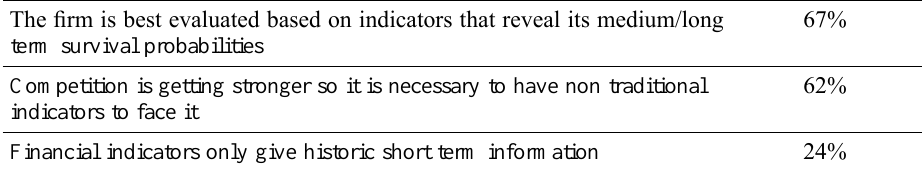
Table 13. Justification for using non financial indicators